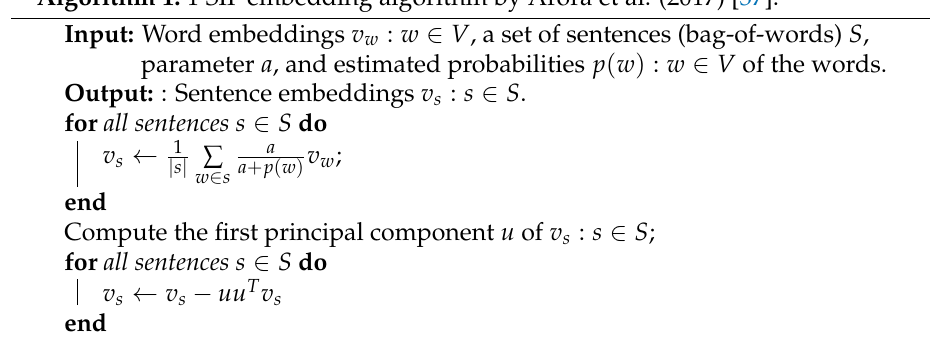
Algorithm 1: 1 SIF embedding algorithm by Arora et al. (2017)